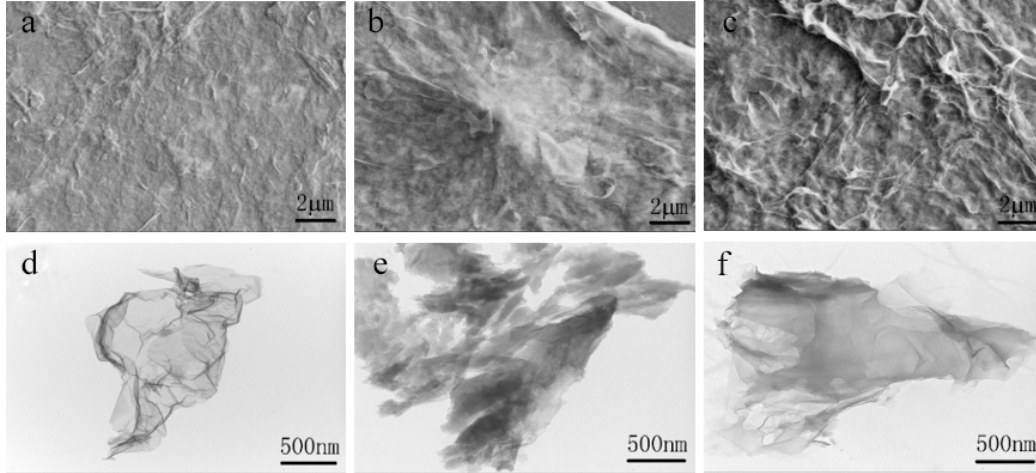
Figure 4. ( a ) SEM image of ERGO / GCE, ( b ) SEM image of Cd(II)- IIP / ERGO / GCE, ( c ) SEM image of IIP / ERGO / GCE, ( d ) TEM image of ERGO / GCE, ( e ) TEM image of Cd(II)-IIP / ERGO / GCE, ( f ) TEM image of IIP / ERGO /